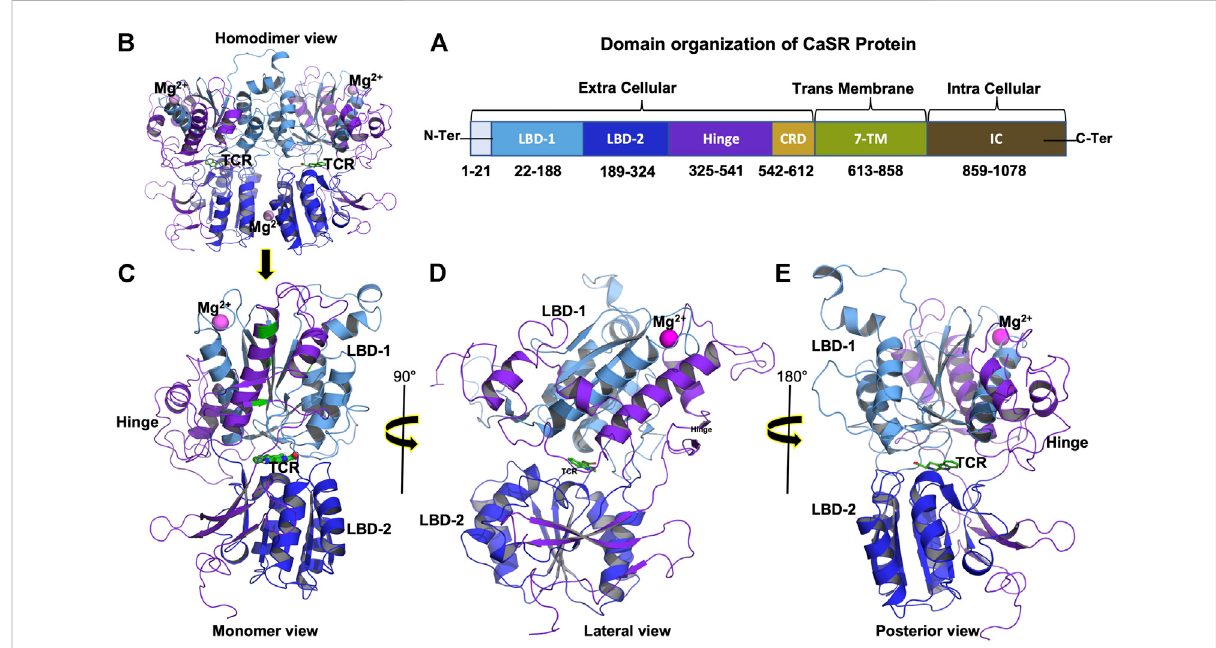
FIGURE 1 (A) Domain organization of CaSR protein showing extracellular, transmembrane, and intracellular domain boundaries, (B) 3D structure of CaSR Extra Cellular Domain (ECD) homodimer (PDB ID: 5FBK), (C) Monomer 3D structure of CaSR ECD, (D) Monomer 3D structure of CaSR ECD lateral view (90 ° ), and (E) Monomer 3D structure of CaSR ECD posterior view (180 ° ). Figure (B) shows CaSR protein structure bound with metal ions Mg2+ (magenta) in LBD1 and at the interface of homodimernear LBD2. Figure (B) also shows Co-agonist L-tryptophan (TCR) (green) bound at the interface of LBD1 and LBD2. Domains in fi gure (B) , (C) , (D) , and (E) are represented as per color scheme used in fi gure 1 (A)